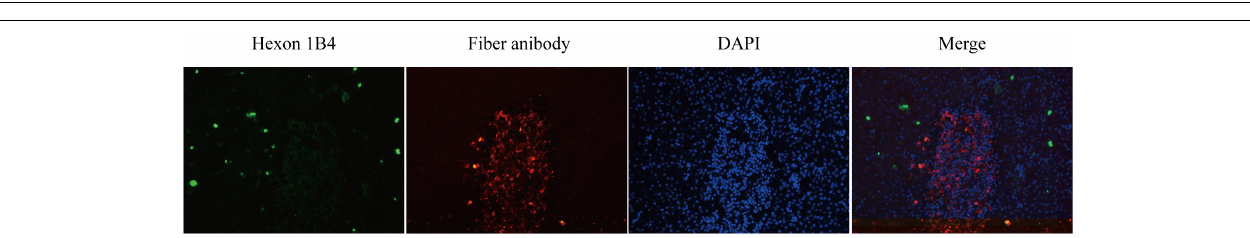
FIGURE 5 | Distribution of viruses in liver of the chickens co-infected with HN and AH720 strains. The slides of liver samples were blocked in 2% BSA and incubated with previously prepared FAdV-4 Hexon 1B4 monoclonal antibody and FAdV-8a Fiber polysera, followed by incubation with Alex Fluor 488 and Alex Fluor 594-conjugated secondary antibodies, respectively. Images were captured by Pannoramic confocal 3D HISTECH system and analyzed by PanoramaStudio Pro software.